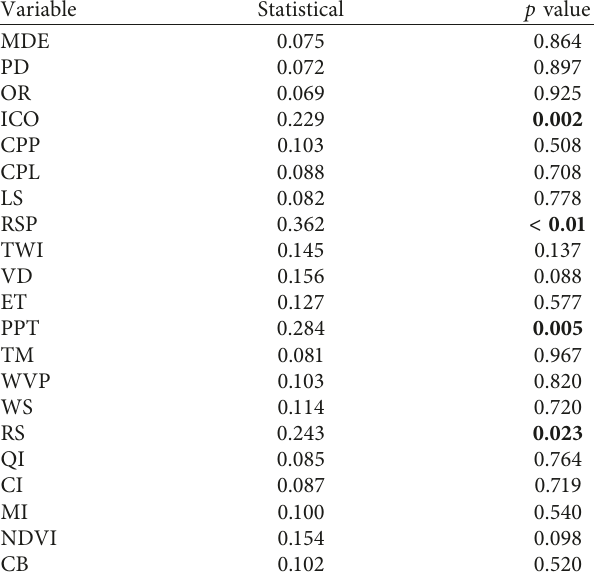
Table 2: Population and sample comparison with Kolmogor- ov–Smirnov test. The null hypothesis is that sample and population have the same distribution. Bold values are those that the hy- pothesis was rejected.